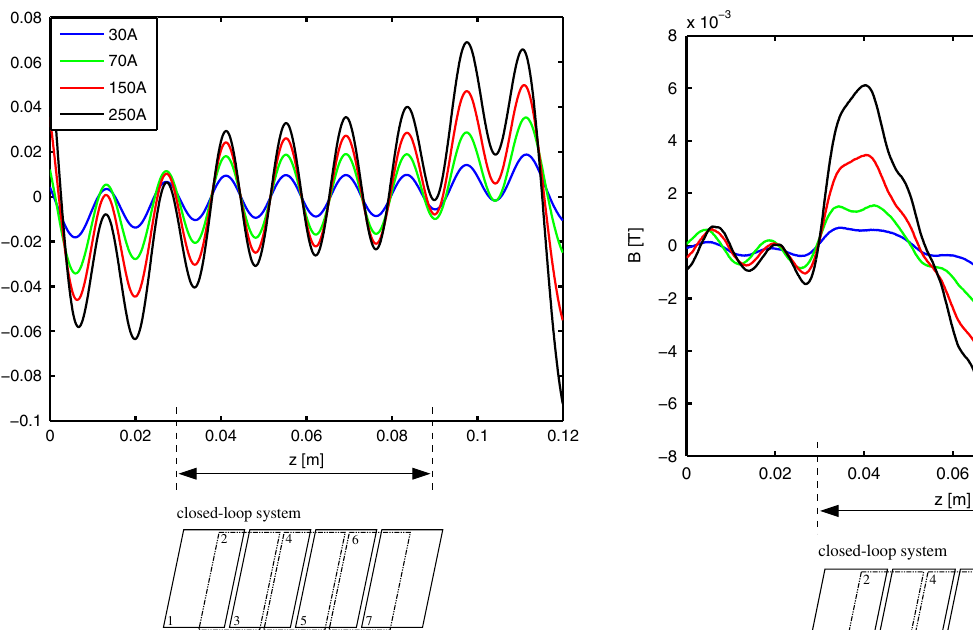
FIG. 5. (Color) The influence of the YBCO closed-loop system on the field shown in Fig. 2 for various undulator